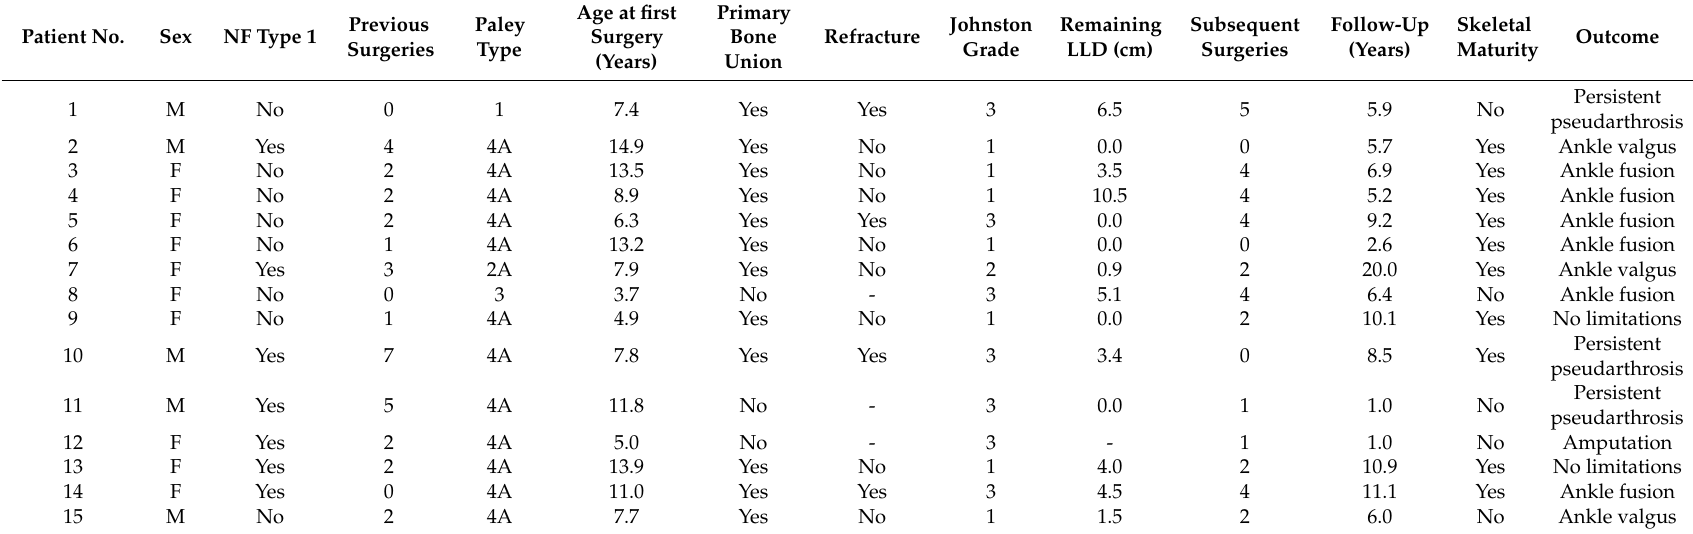
Table 2. Results Group B: Excision of the pseudarthrosis, acute compression and extrafocal lengthening. Patient